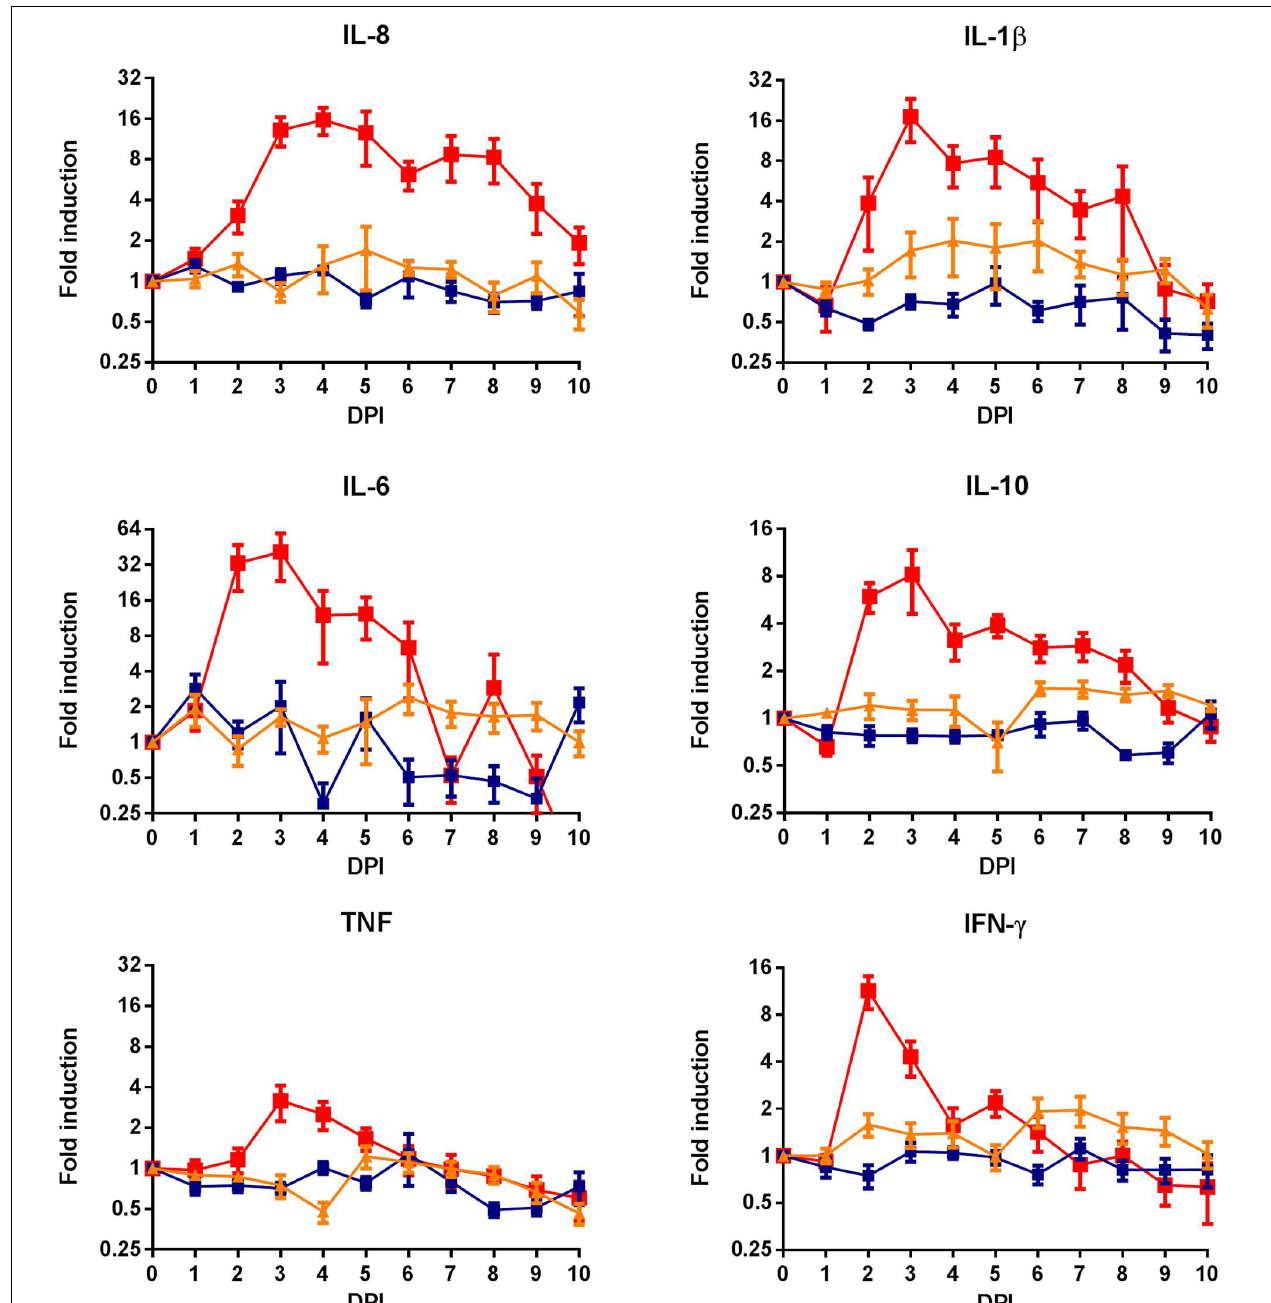
FIGURE 4 | Cytokine mRNA responses in lambs following RVFV infection or contact-exposure. Whole blood samples were collected from lambs experimentally infected with RVFV (red), contact-exposed lambs (orange) and separately housed, non-exposed control lambs (blue). Blood samples were collected in PAXgene tubes for a period of 10 days. RNA was isolated from PBMCs and used for reverse-transcription. Results represent SYBR green based qRT-PCRs of IL-8, IL-1 β , IL-6, IL-10, TNF- α , and IFN- γ . Gene expression levels were normalized with the house keeping gene gapdh . To determine gene-expression kinetics, fold-inductions compared to day 0 were calculated. Error bars represent averages with